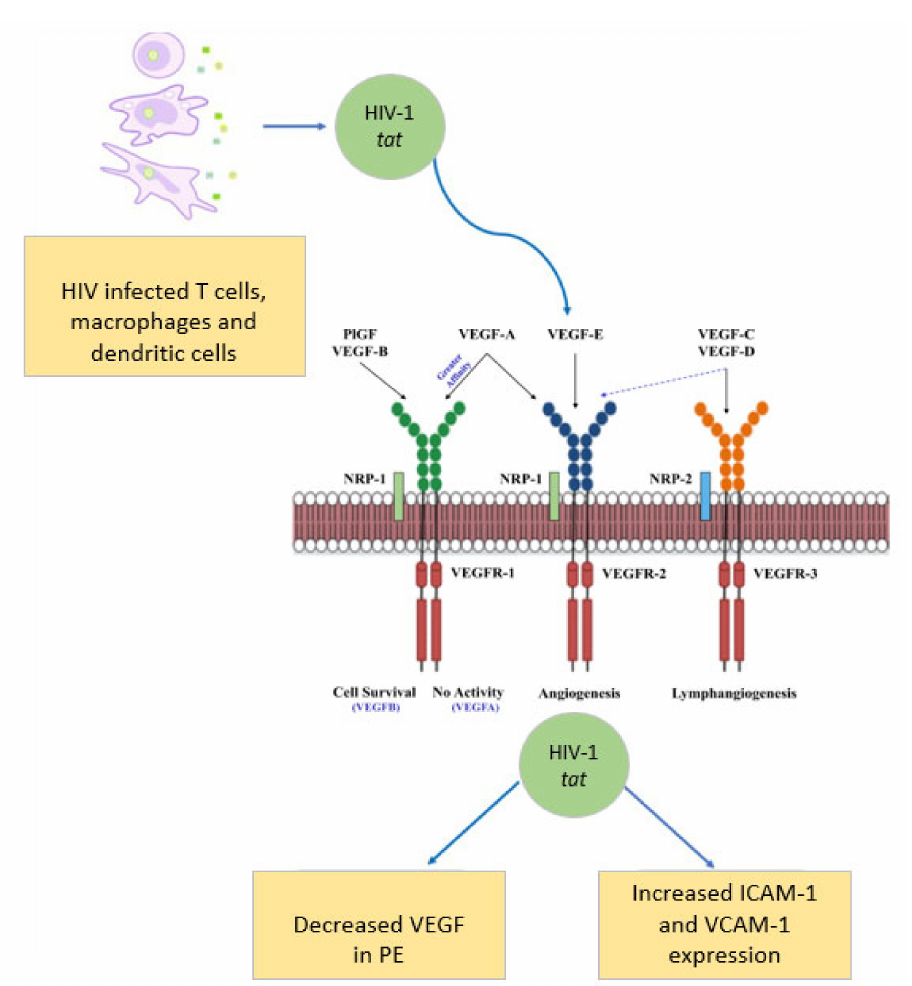
Figure 2. HIV-1 accessory protein Tat is released from infected cells, decreases bioavailability of VEGF and increases cell adhesion expression, thereby promoting endothelial cell dysfunction. Adapted from